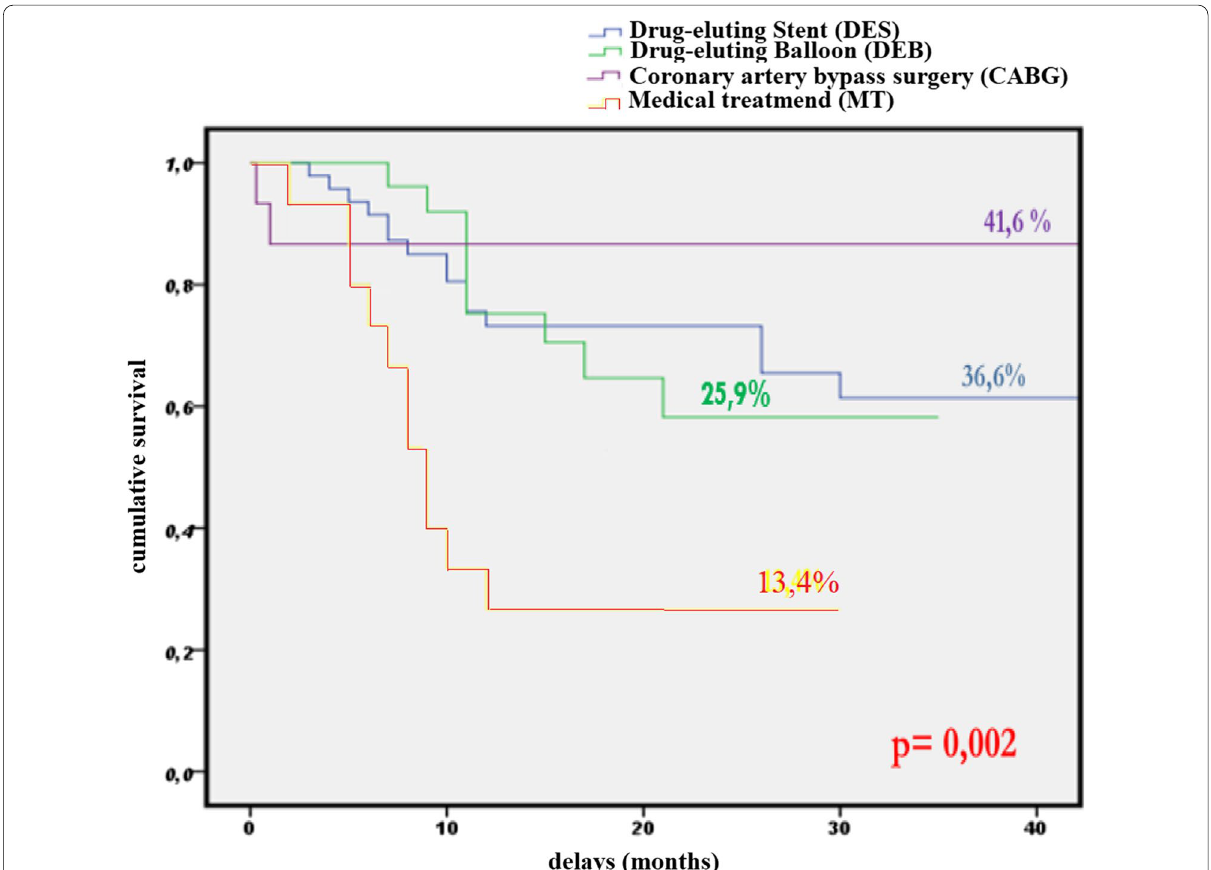
Fig. 1 Major adverse cardiac events free survival according to in-stent restenosis treatment strategy. Kaplan–Meier curves represent major adverse cardiac events (MACE)-free survival according to in-stent restenosis treatment strategy. Patients, who received medical treatment only, had the lowest MACE-free survival rate (13.4%). On the contrary, patients, who underwent coronary artery bypass graft surgery (CABG), had the best MACE-free survival rate (41.6%). They were followed by patients treated with percutaneous coronary intervention (Drug-eluting stents: 36.6% and drug-eluting balloon: 25.9%)